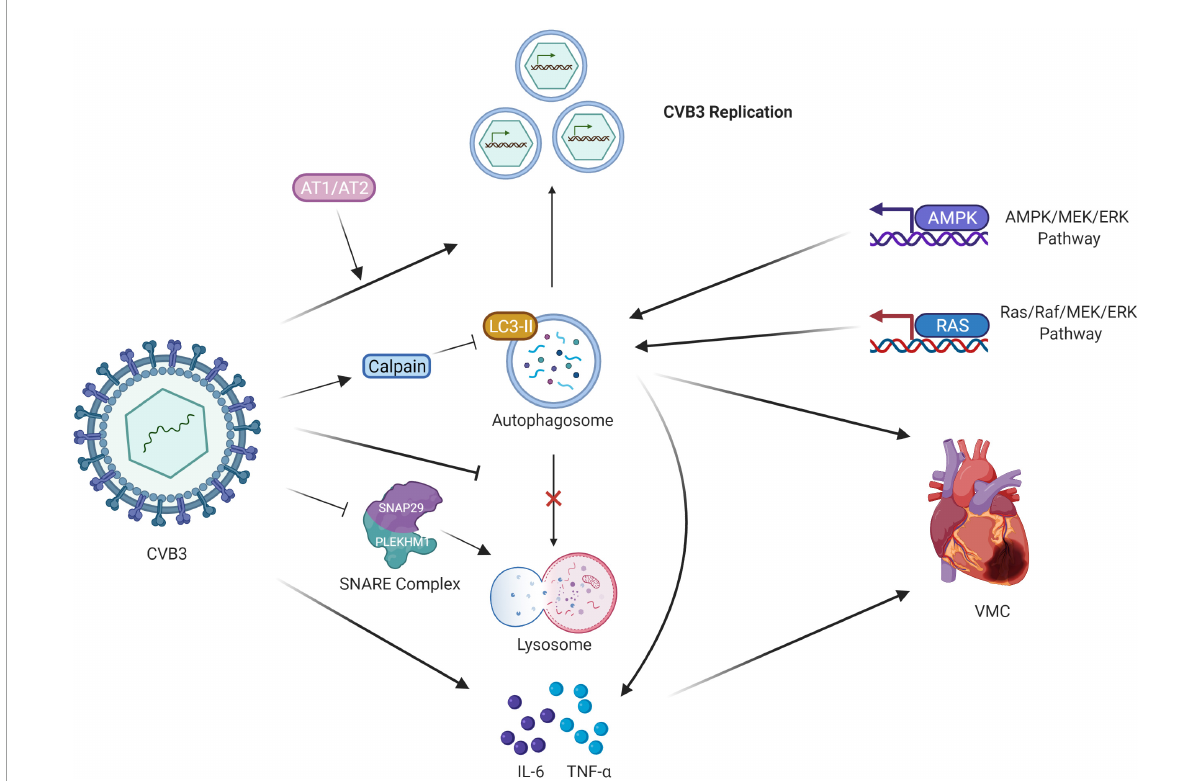
FIGURE2 Regulation of CVB3 and autophagy in VMC. CVB3 infection triggers the formation of autophagosomes and uses the autophagosomal pathway for replication. CVB3 infection in cardiomyocytes activated calpain and increased. The inhibition of calpain activity led to the accumulation of LC3-II protein expression, impairing the autophagic flux. AT1 and AT2 regulate cardiomyocyte autophagy activity by propagating viral replication, thus triggering autophagic cell death. CVB3 might directly or indirectly induce autophagy via the AMPK/MEK/ERK and Ras/Raf/MEK/ERK signaling pathways. CVB3 inhibits the fusion of lysosomes with autophagosomes. CVB3 specifically targets the SNARE protein SNAP29 and the adaptor protein PLEKHM1, both of which regulate autophagosome fusion, for cleavage through the catalytic activity of viral proteinase 3C; this process ultimately impairs the formation of SNARE complexes. The release of proinflammatory cytokines also participates in the cardiac fibroblasts caused by CVB3 infection, and the downregulation of autophagy suppresses them. CVB3, coxsackievirus B3; VMC, viral myocarditis; LC3, light chain 3; AT1 and AT2, Type I and II angiotensin II